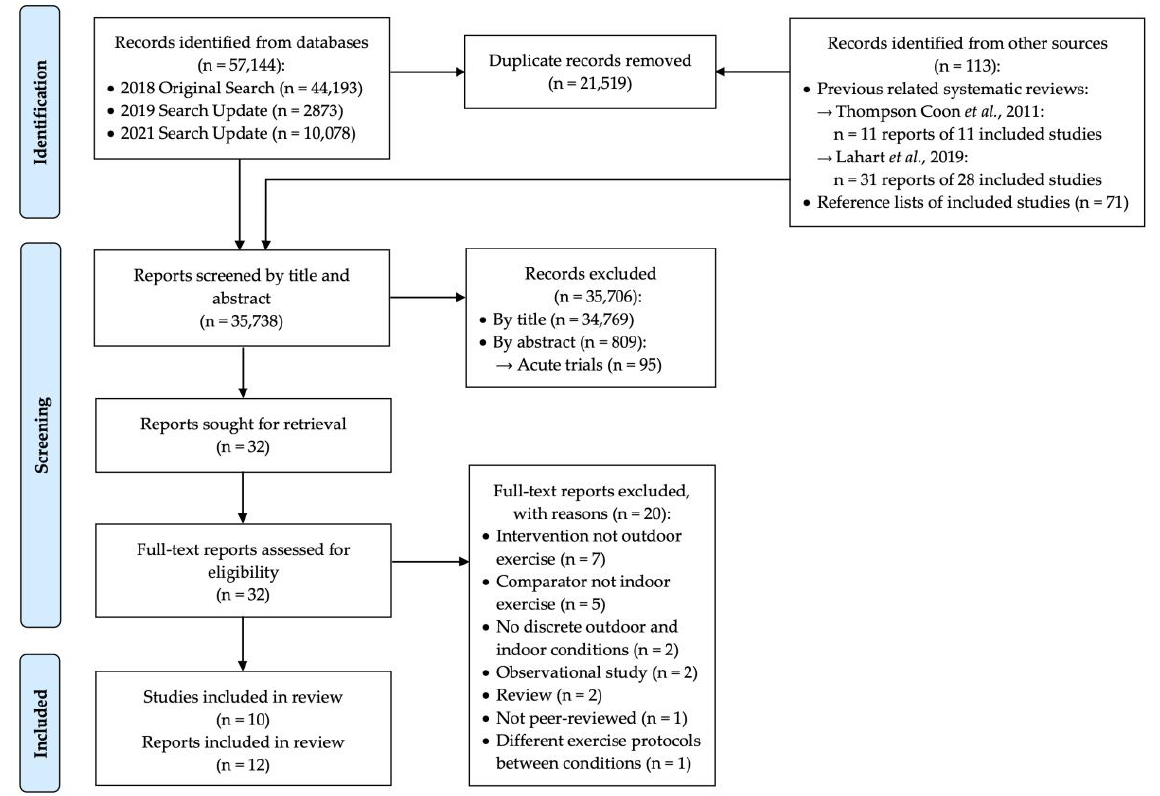
Figure 1. PRISMA flow diagram of article search and screening process.